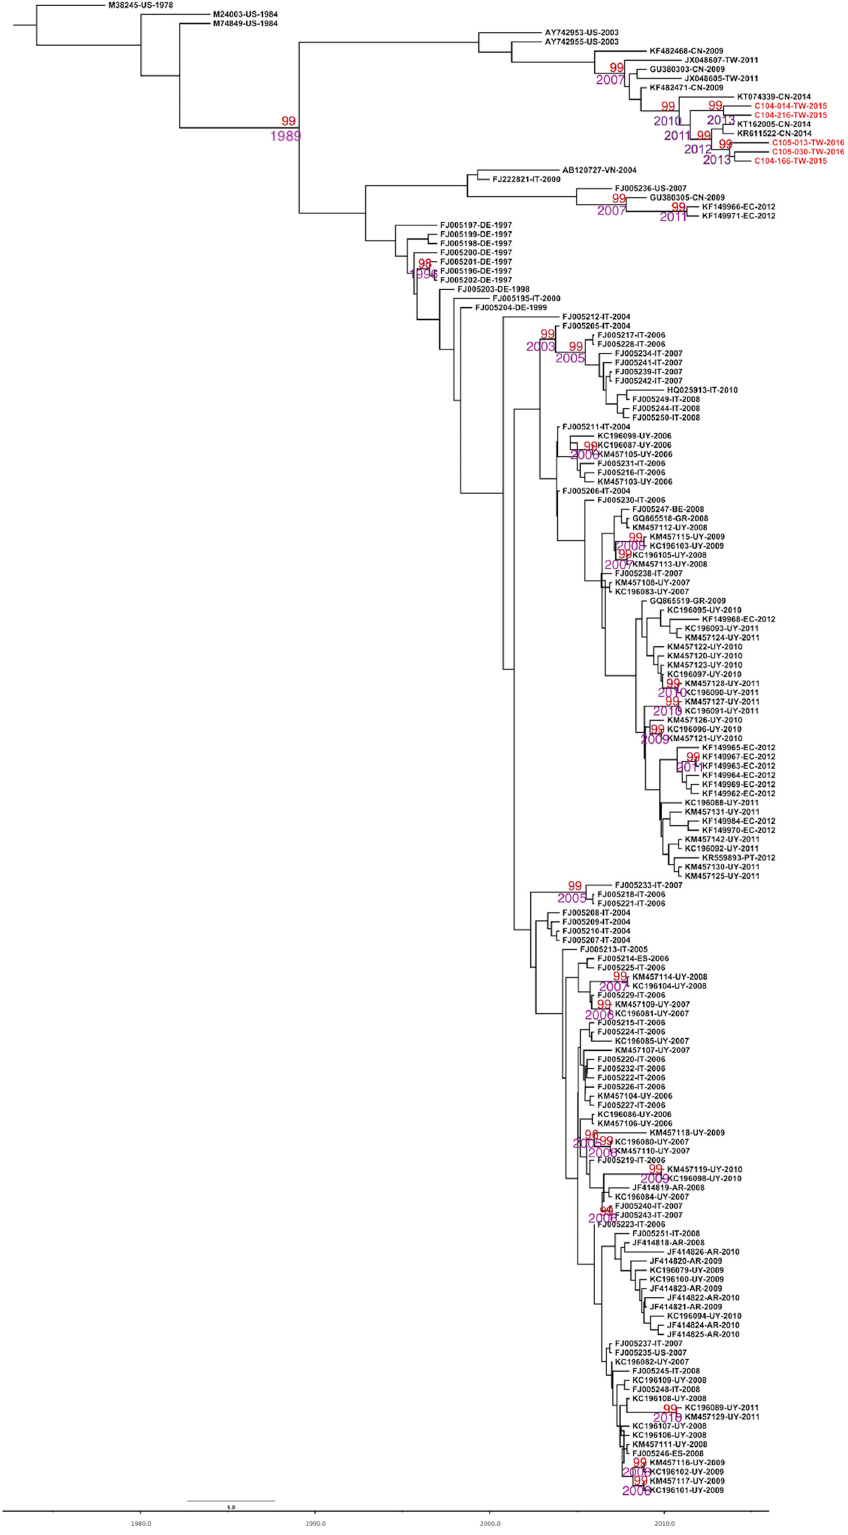
Figure 1. Maximum clade credibility (MCC) tree of CPV-2 inferred from 163 complete VP2 sequences. The MCC tree was constructed with 10% burn-in by Tree Annotator v 1.8 implemented in the BEAST software package. Red text represents the Taiwanese CPV-2c isolate in the present study. Numbers beside the branches are posterior probability values and branch time. Only posterior probability values above 0.95 are shown.